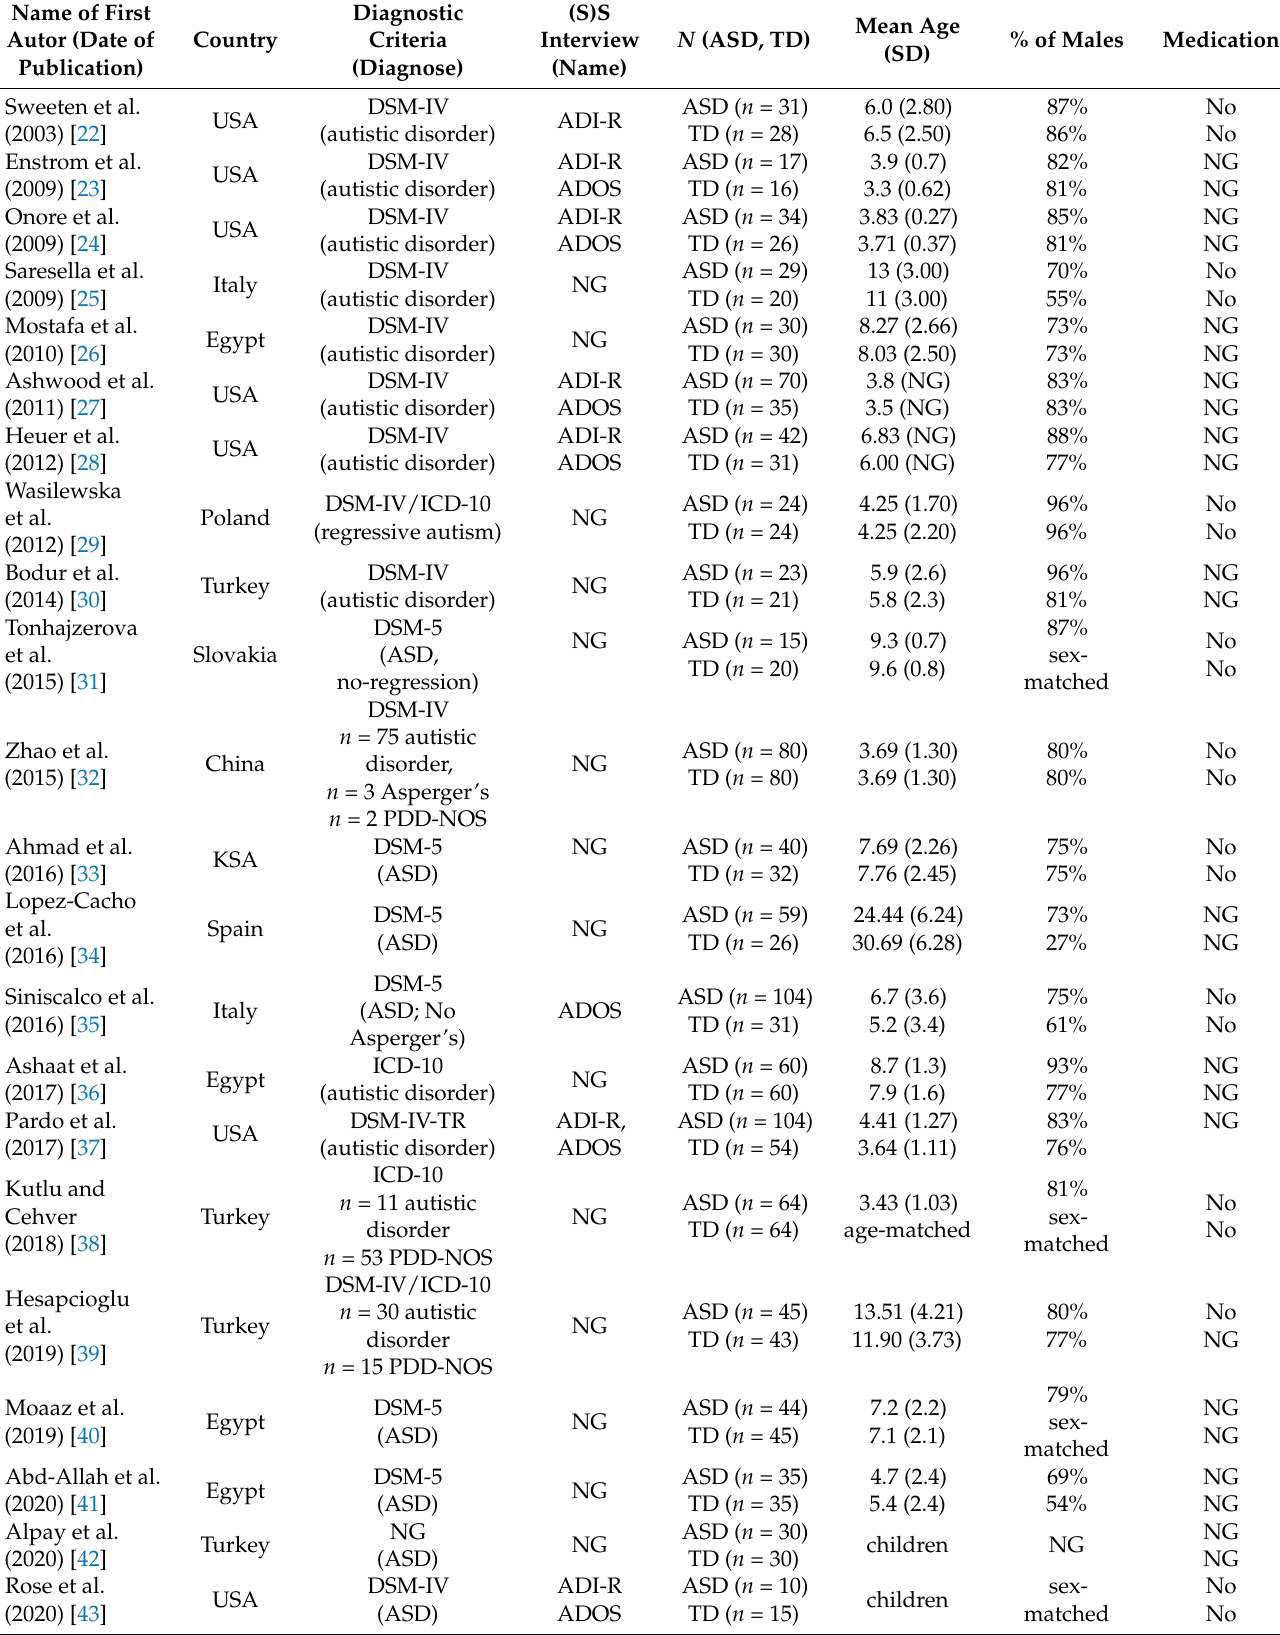
Table 1. Characteristics of included